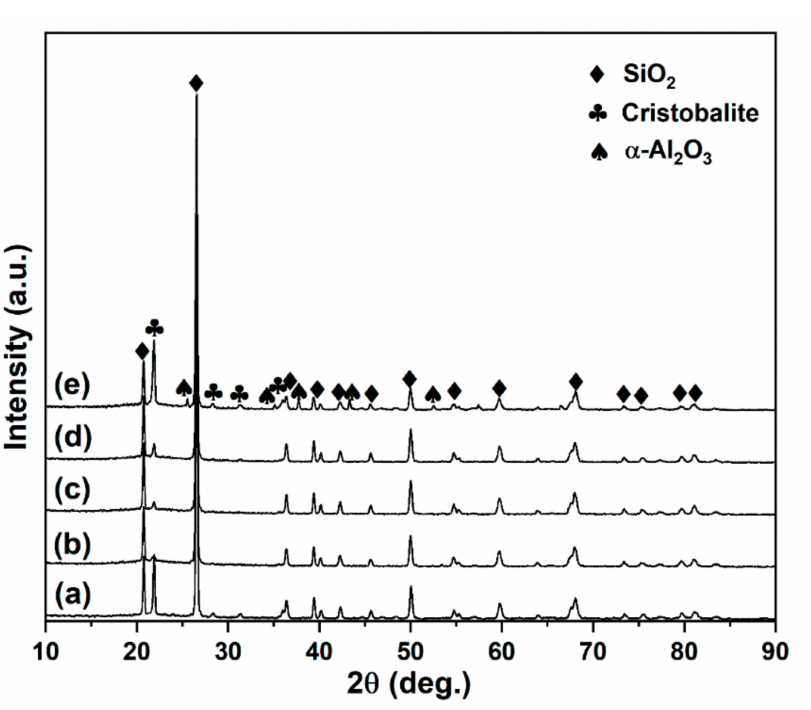
Figure 4. XRD patterns of the samples, ( a ) S1; ( b ) S2; ( c ) S3; ( d ) S4; ( e )